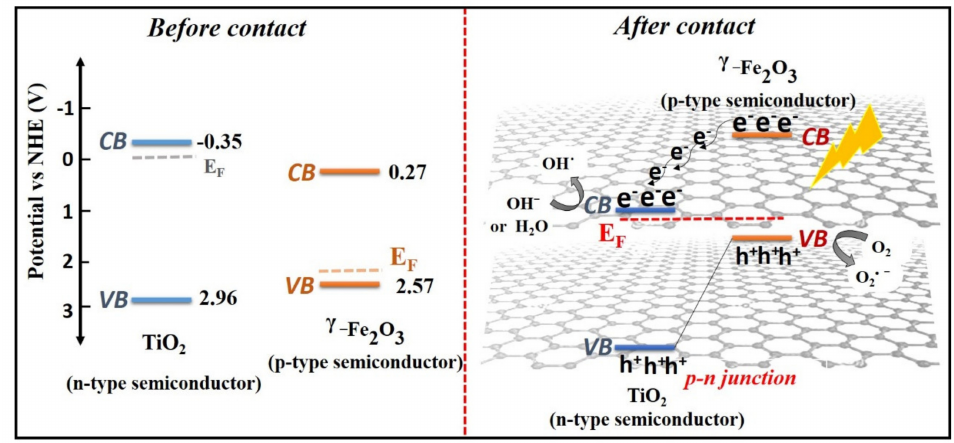
Figure 14. Schematic illustration of the proposed reaction mechanism for the photocatalytic degradation process in the presence of the prepared